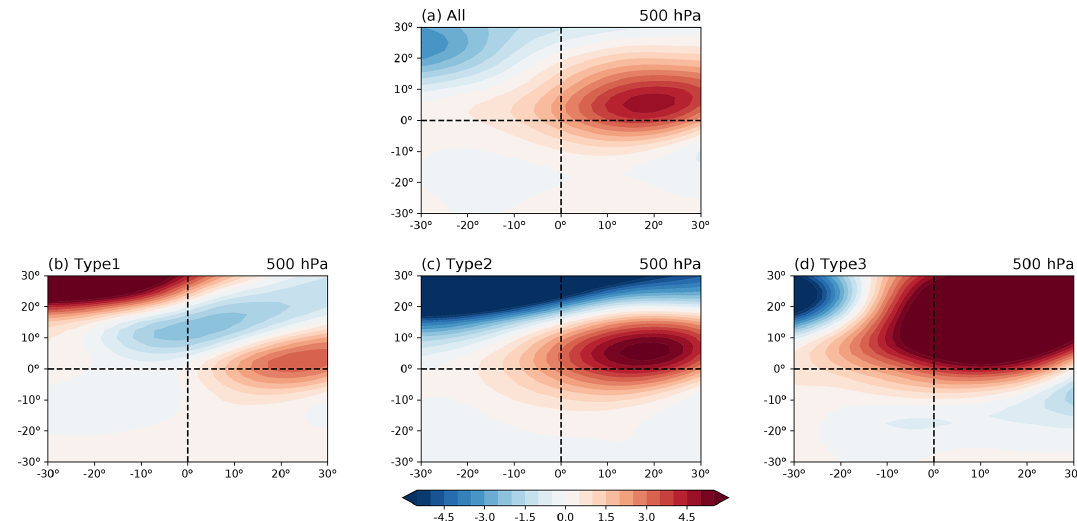
Figure 2. (a) Composite anomalies of GPH at 500hPa (units: gpm) during all severe HD EC in 853 stations. (0 ◦ , 0 ◦ ) represents the location of stations. Panels (b) , (c) , and (d) are the same as (a) but for three sub-types.